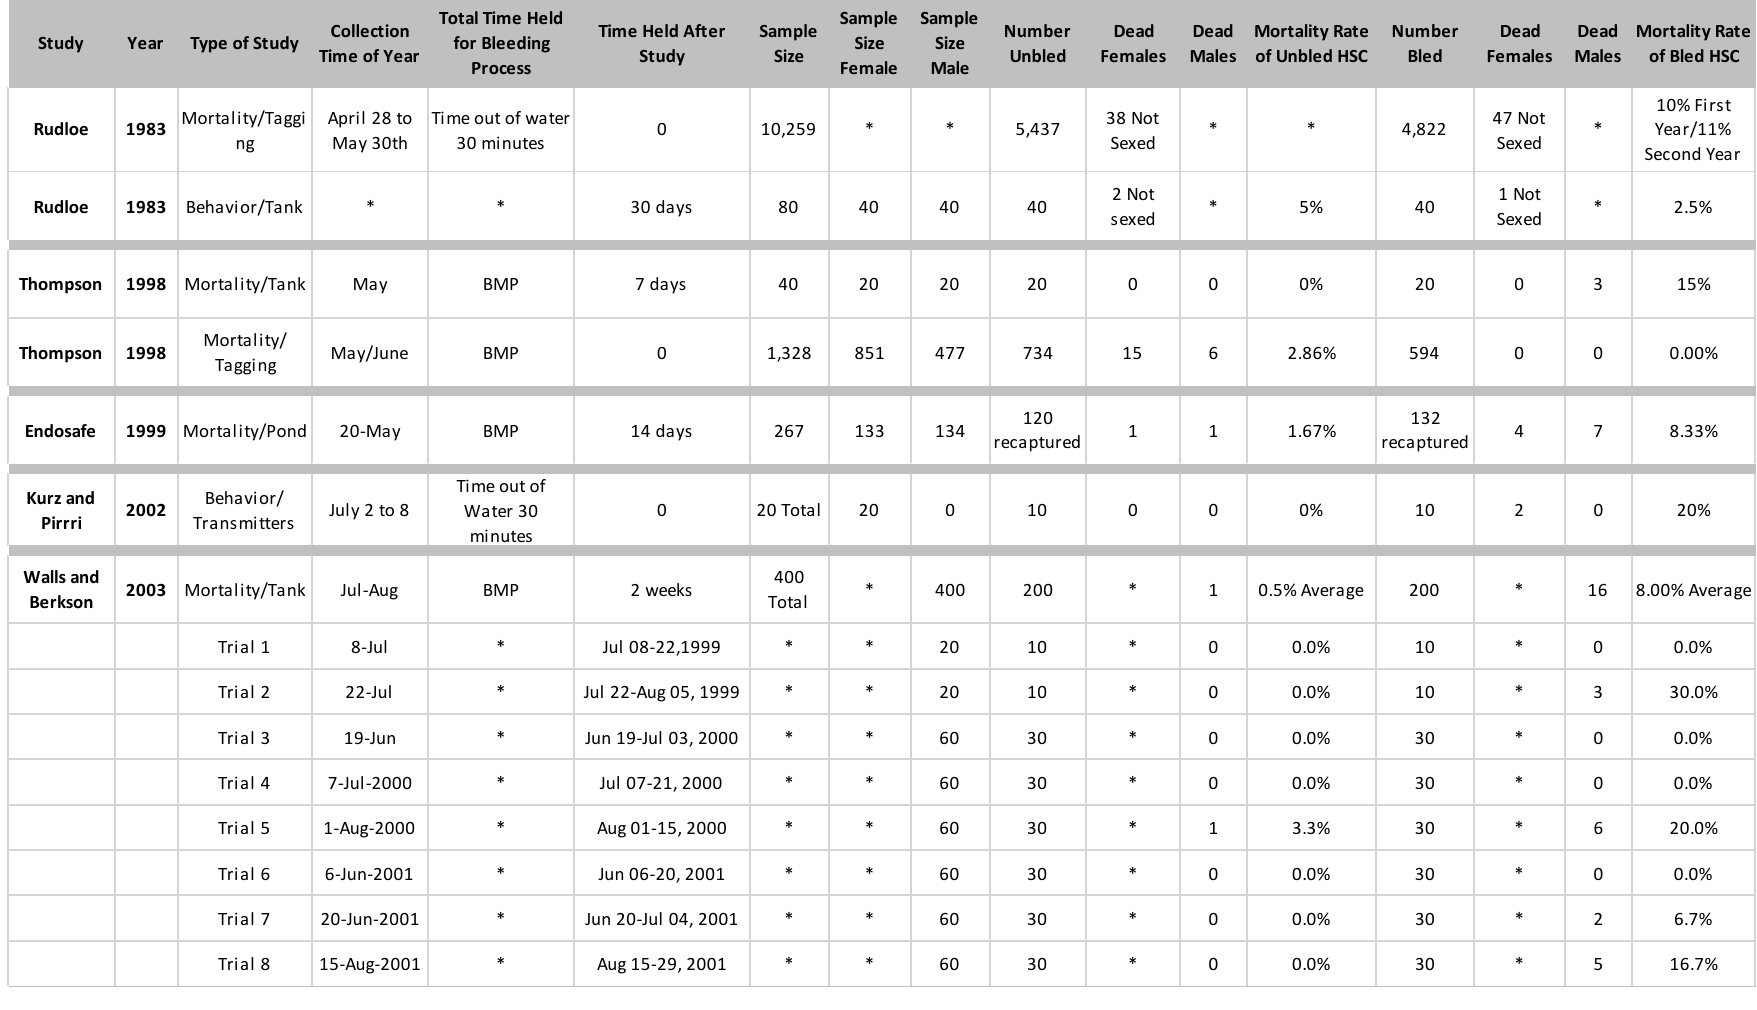
Table 2. Mortality studies